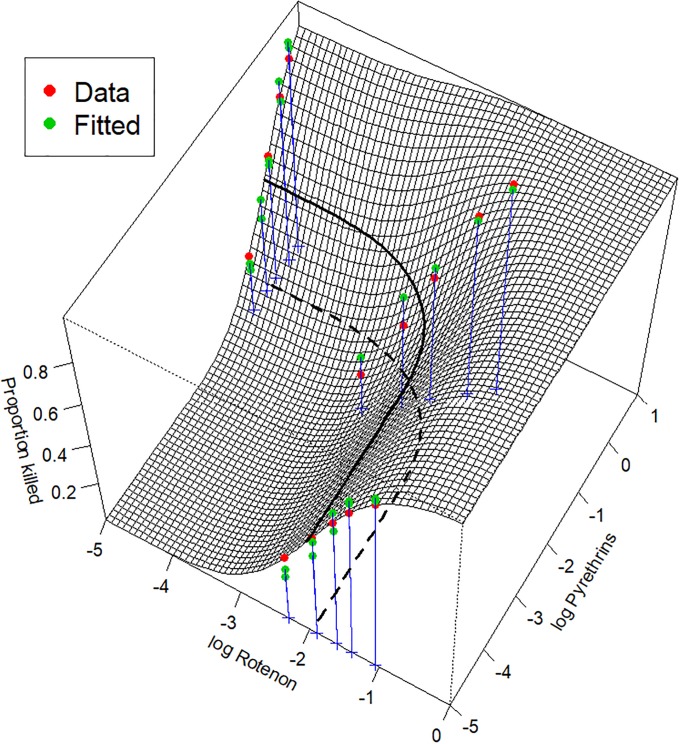
Fit of 1:5 ratio of rotenone to pyrethrins data by the probit-based two-drug copula mortality function.The bold curve depicts the combination of doses of the two drugs that leads to the expected 50% fly kill (its projection on the xy-plane is depicted as the dashed line). The synergy between drugs is statistically significant with p-value = 0.0086.